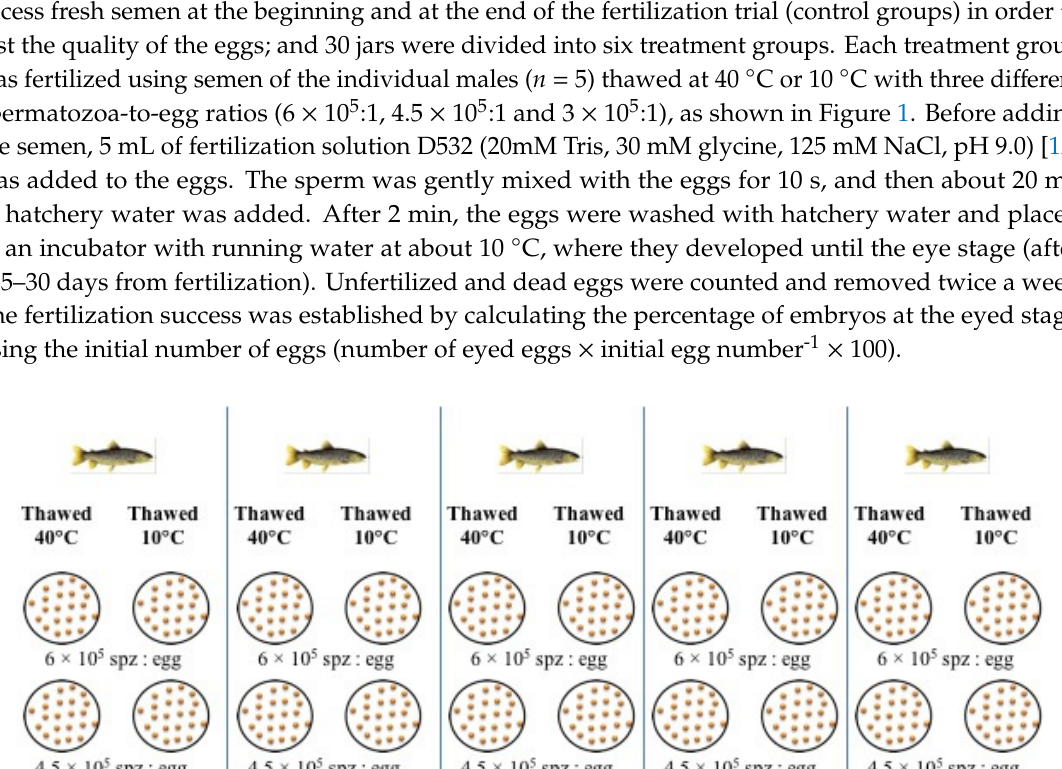
Table 1. Computer-Assisted Sperm Analysis (CASA) parameters recorded for fresh semen or frozen semen (mean ± SE) undergoing two different thawing rates ( n = 5). Treatment